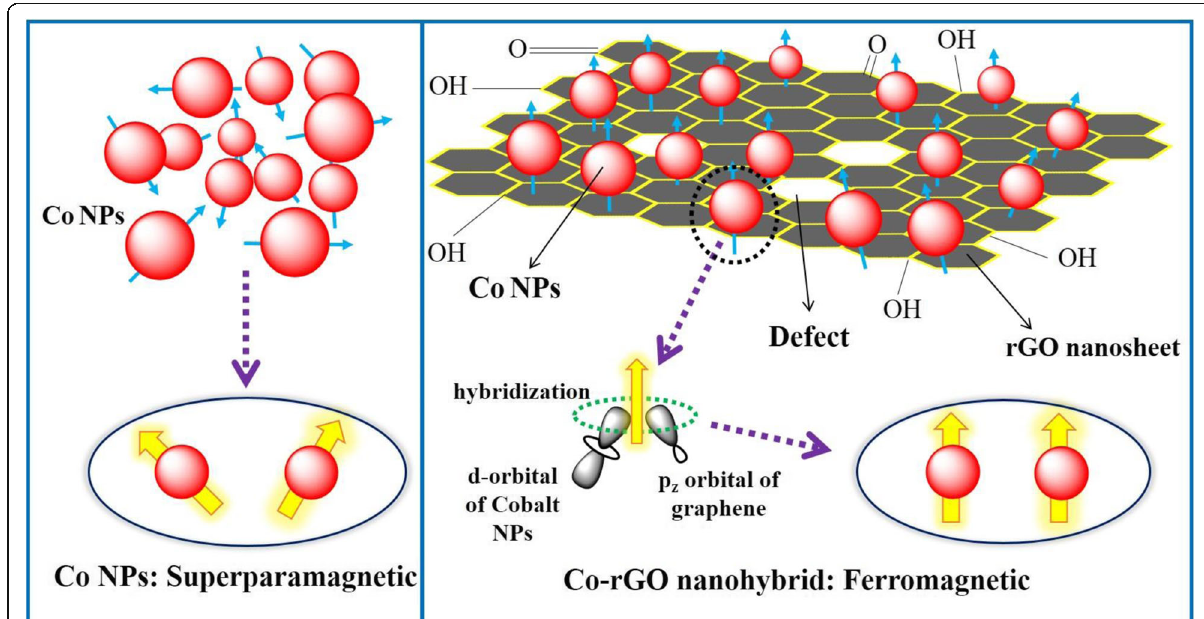
Fig. 6 Schematic model for SPM and FM behavior in Co NPs and Co-rGO nanohybrid,